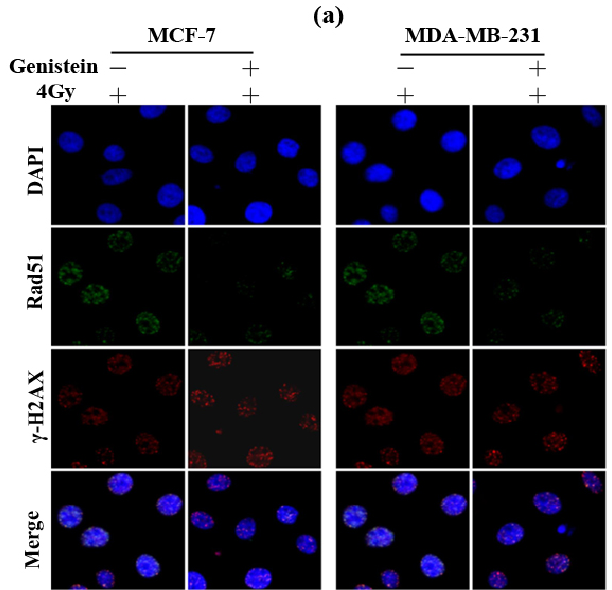
Figure 7. Effect of genistein combined with X-ray irradiation on the cell repair system and apoptosis of MCF-7 and MDA-MB-231 cells. (a) Co-localization of Rad51 (green points) and γ -H2AX (red points) foci; nuclear staining was done with DAPI (blue). Scale bars represent 20 μ m; (b) Representative cell apoptosis of three independent experiments at 12 h post-irradiation; (c) Representative cell apoptosis of three independent experiments at 24 h post-irradiation; (d) Cell apoptotic rates at 12 h post-irradiation; (e) Cell apoptotic rates at 24 h post-irradiation. All data are presented as means ± SD from three independent experiments. * p < 0.05, ** p < 0.01 versus control group; # p < 0.05, ## p < 0.01 versus X-rays